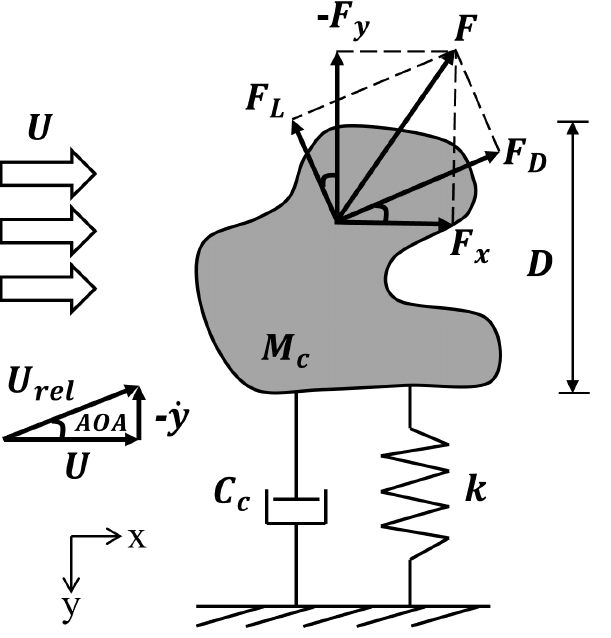
Figure 6. Schematic of a bluff body experiencing transverse galloping in a fluid